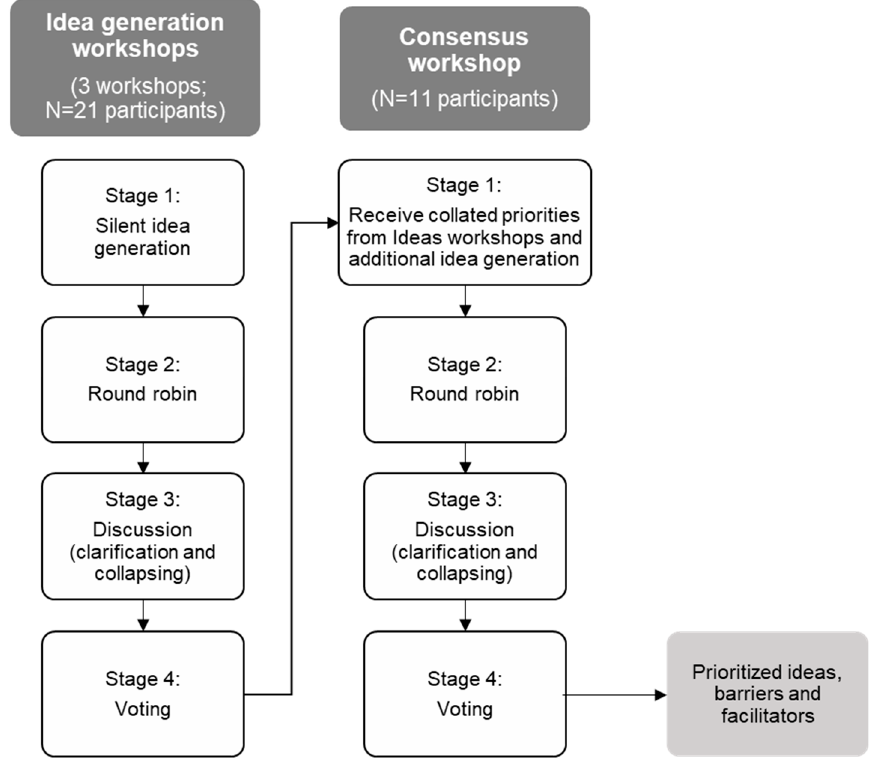
Figure 1. Flowchart of nominal group technique procedure for idea generation and consensus workshops.